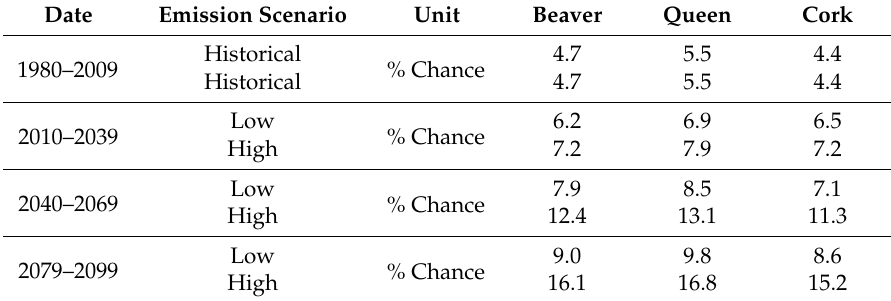
Table 8. Percent chance of a stressful event occurring under future climate scenarios. Results for